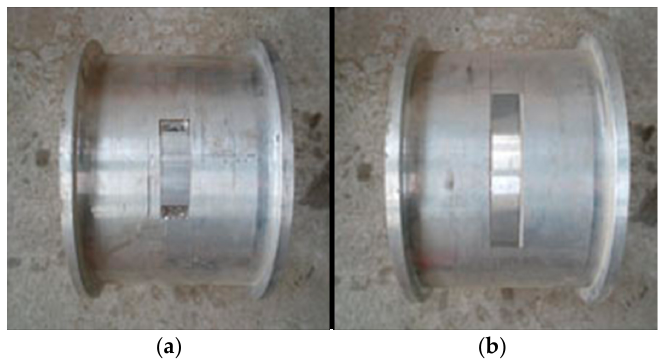
Figure 5. Bar damage scenarios: ( a ) 5% damage; ( b ) 10% damage.